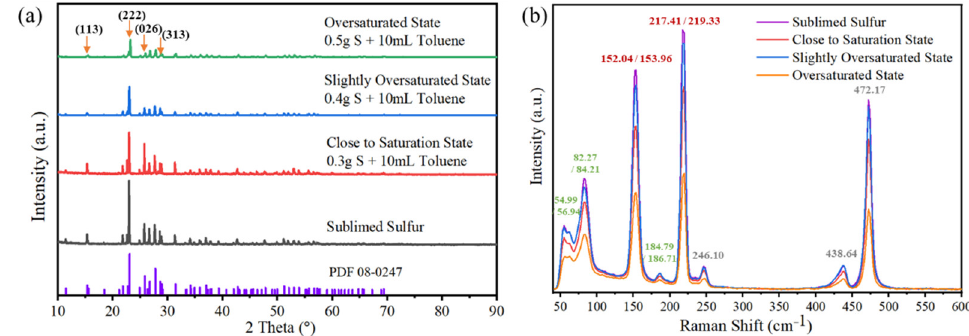
Figure 3. XRD patterns ( a ) and Raman spectroscopy ( b ) of sulfur with different saturations precipi- tated in toluene.